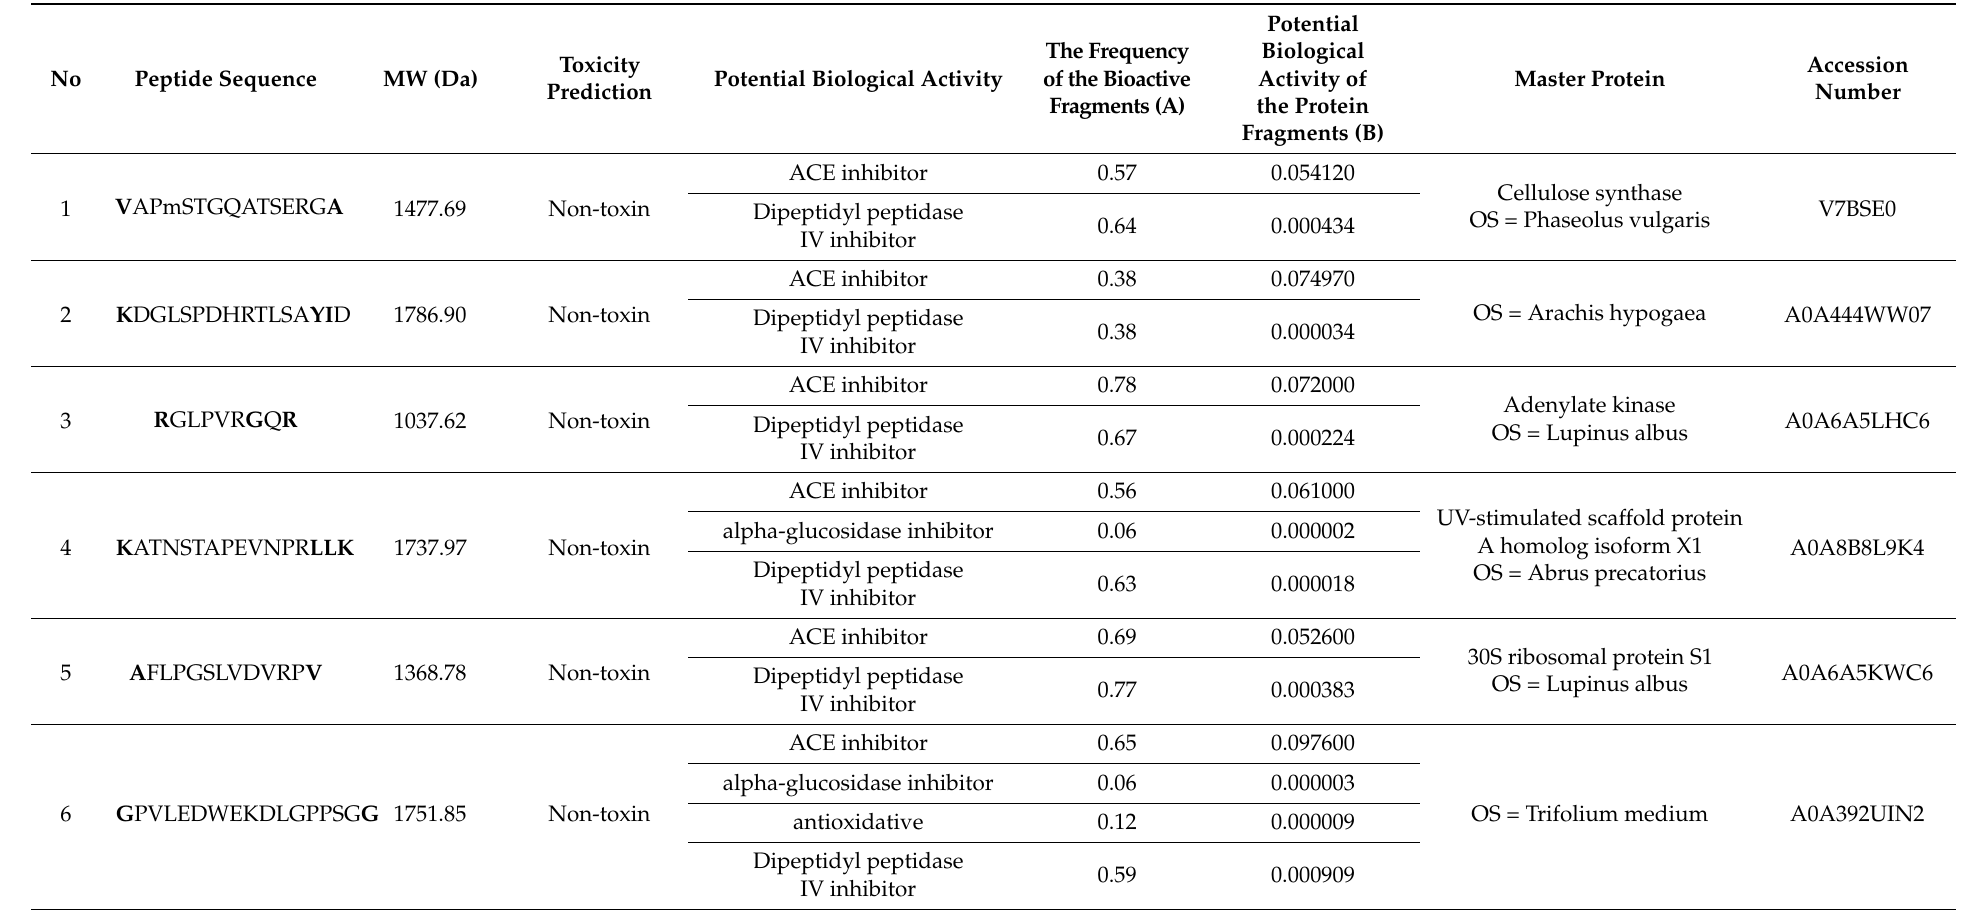
Table 3. Peptide sequence of the germinated lamtoro gung flour obtained from the GID simulation <1–3.5 kDa peptide